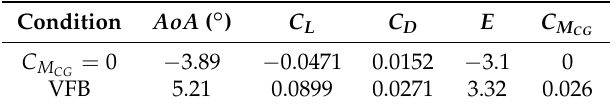
Table 5. Aerodynamic parameters for the zero pitching moment ( C M (VFB) conditions of the CFD case with the scramjet